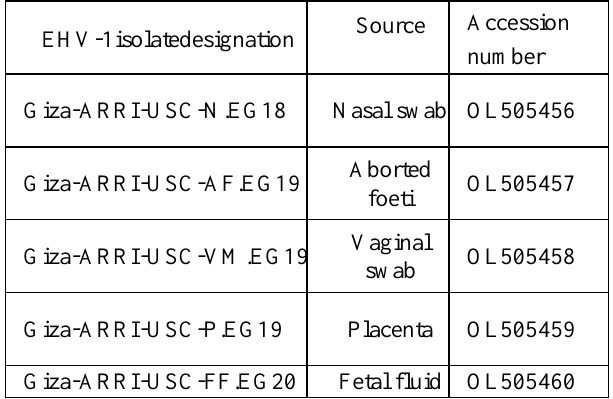
Table 2: The designation and the